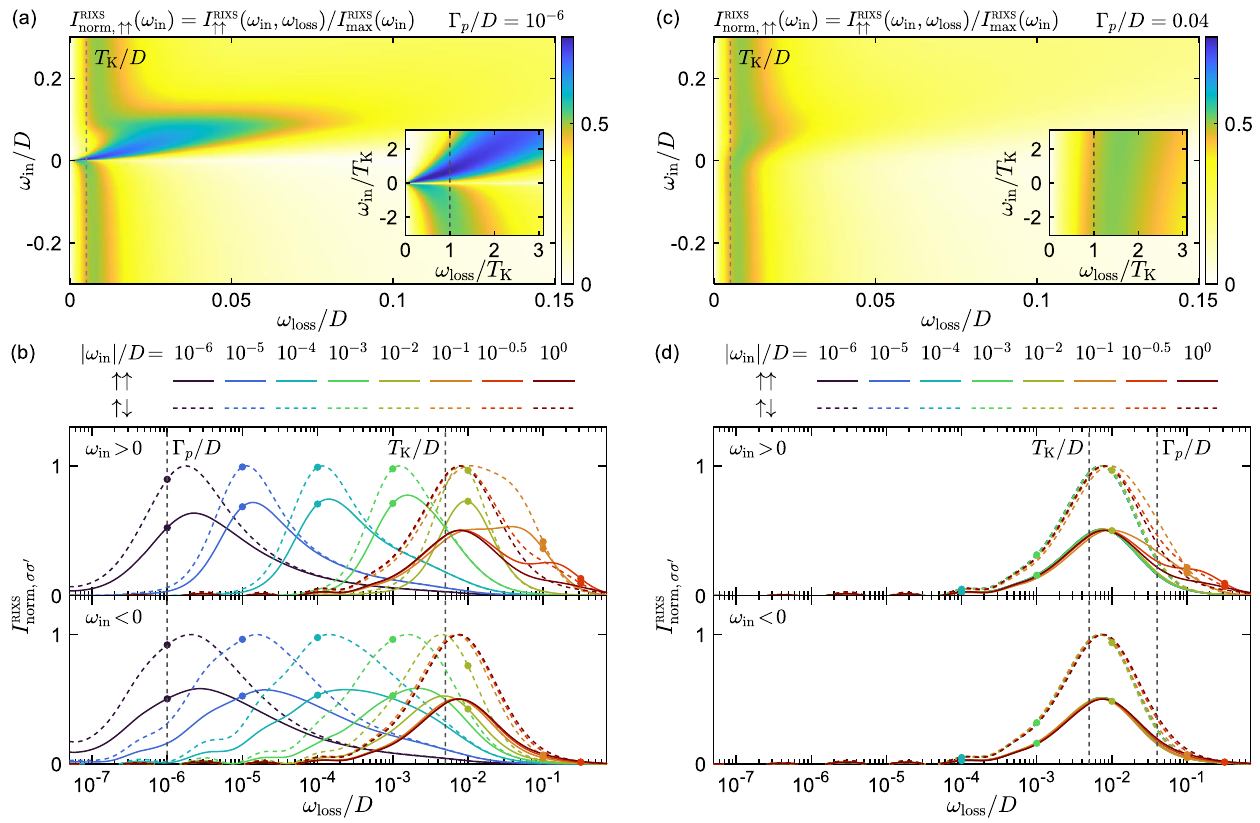
FIG. 13. Normalized RIXS spectrum I RIXS headers) and the broadening width smaller (see Appendix C). We normalize I RIXS σσ since I RIXS ↑↓ has larger maxima than I RIXS ↑↑ [compare dashed to solid lines in (b)]. We chose Γ (d). For both cases, the same layout is used as for Fig. 10: (a),(c) Color-scale plots using linear frequency scales, and (b),(d) line cuts using a logarithmic frequency scale to show the ω A fluorescence-type peak or shoulder is seen at ω a Raman-type peak occurs at ω